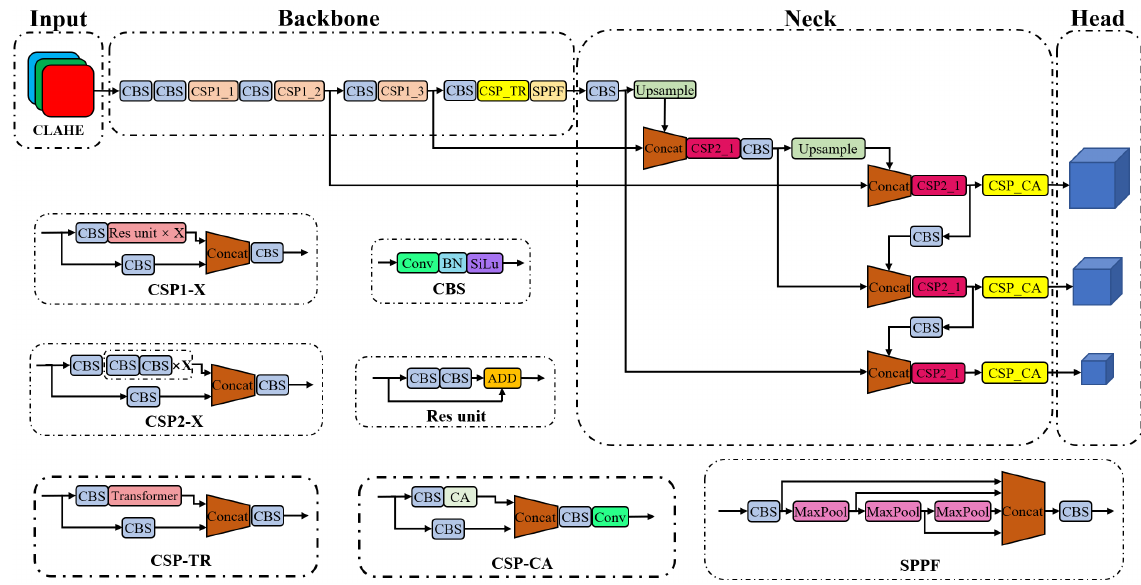
Figure 2. Overall structure of the proposed TC-YOLO network.